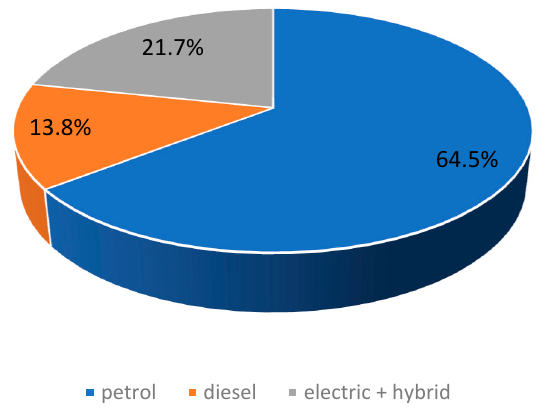
Figure 1. The ratio of petrol, diesel, and electric vehicles in Romania, in 2022. The evolution of registered vehicles in 2022 can be observed in Table 1, along with the registration variations in 2021 and 2022 [7].